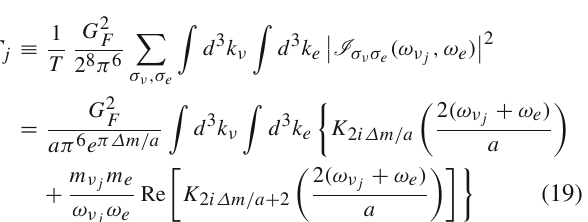
of Ref. [23], where asymptotic neutrinos are assumed